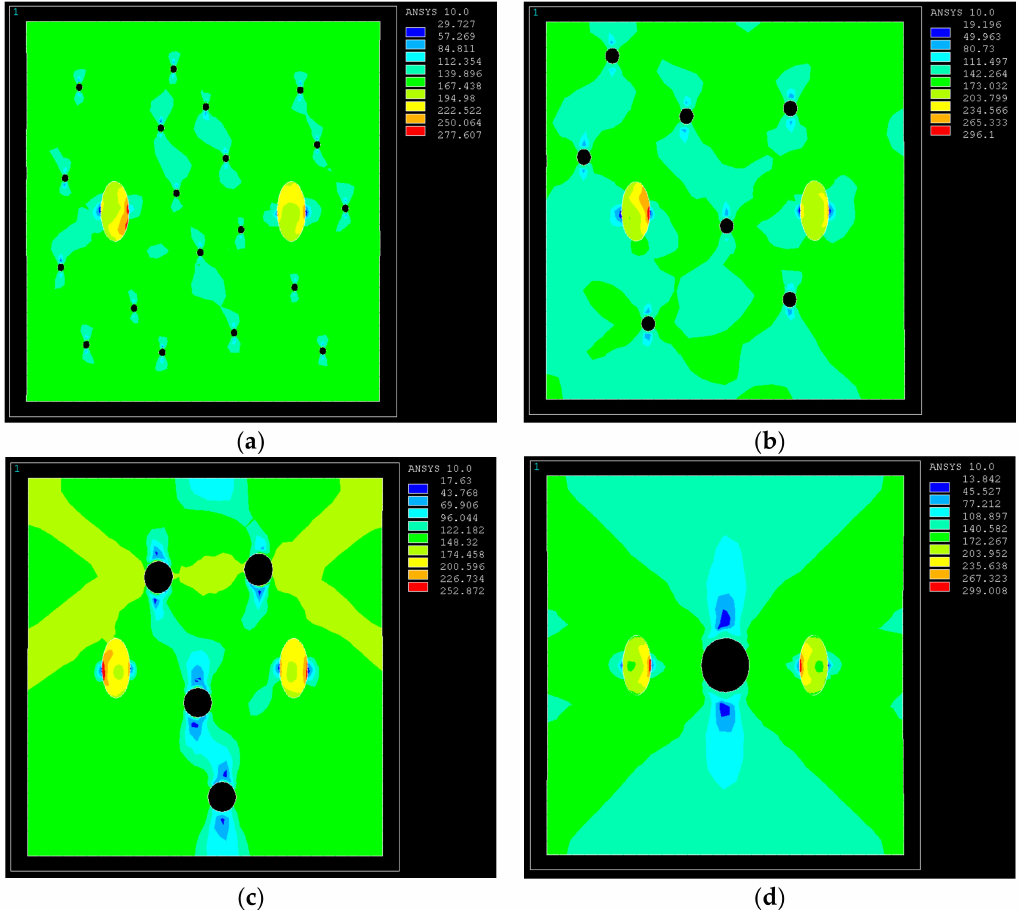
Figure 5. Stress diagrams of GRANs with different pore sizes, ( a ) 0.5 µ m, ( b ) 1 µ m, ( c ) 2 µ m, and ( d ) 3 µ